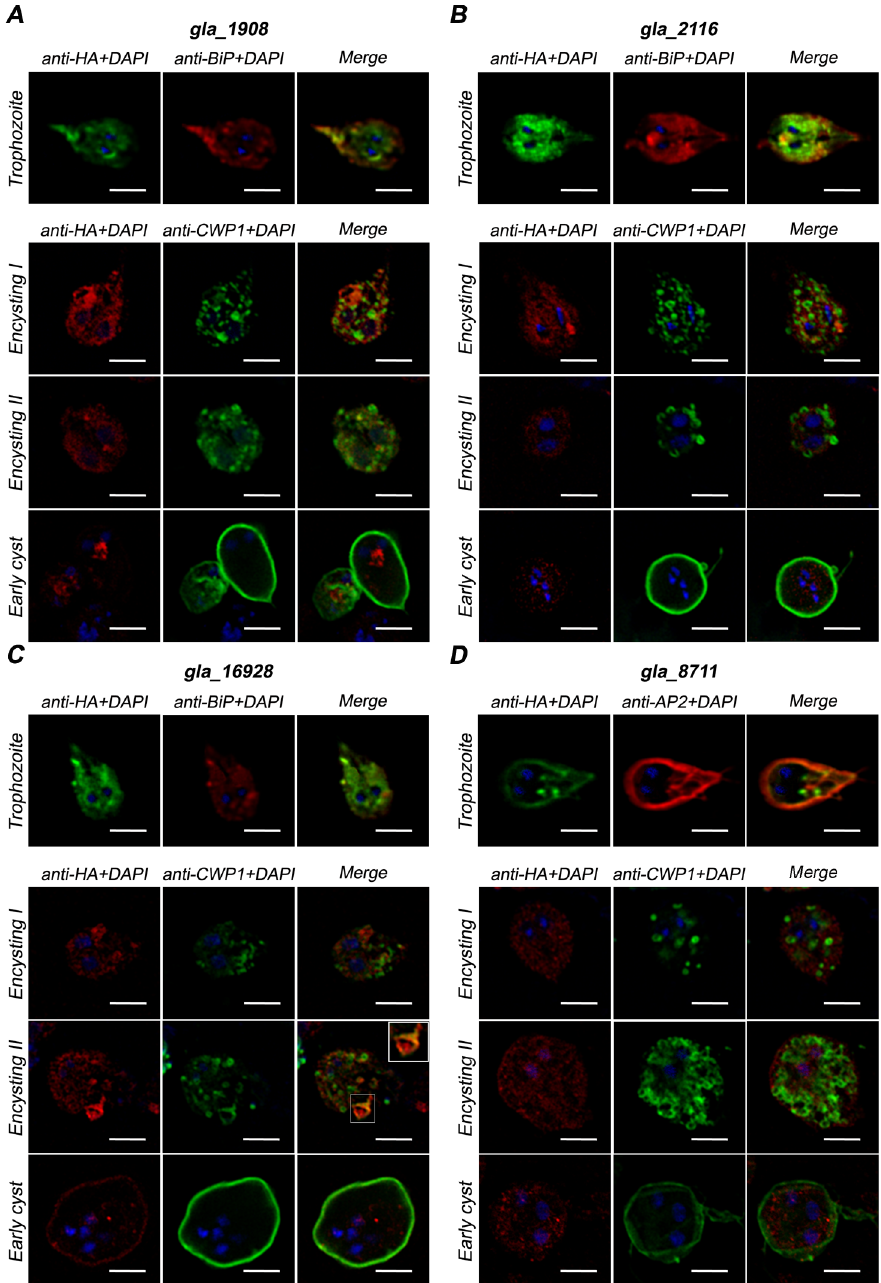
Figure 8. Localization of DHHC-HA proteins in trophozoites and effect of DHHC-HA overexpression in encystation. Subcellular localization of gla_1908-HA (A), gla_2116-HA (B), gla_16928-HA (C), or gla_8711-HA (D) in trophozoites or encysting parasites. For trophozoites, gla_1908-HA, gla_2116-HA or gla_16928-HA were stained with anti-BiP (ER) mAb, anti-HA mAb and DAPI; gla_8711-HA was stained with anti-AP2 (PVs) mAb, anti-HA mAb and DAPI. For encysting parasites, after 48 h of encystation dhhc-ha transgenic parasites were stained with anti-HA mAb, anti-CWP1 mAb and DAPI. The cells were analyzed by fluorescence microscopy. One representative cell from each stage is shown. Yellow areas in trophozoites indicate co-localization between DHHC-HA and ER (gla_1908-HA, gla_2116-HA or gla_16928-HA), or between DHHC-HA and PVs (gla_8711-HA). Yellow areas in encysting parasites indicate co-localization between DHHC-HA and CWP1. The inset in C ( gla_16928 transgenic encysting II parasites) corresponds to the zoomed area indicated by the lined box. Scale bars=5 m m.